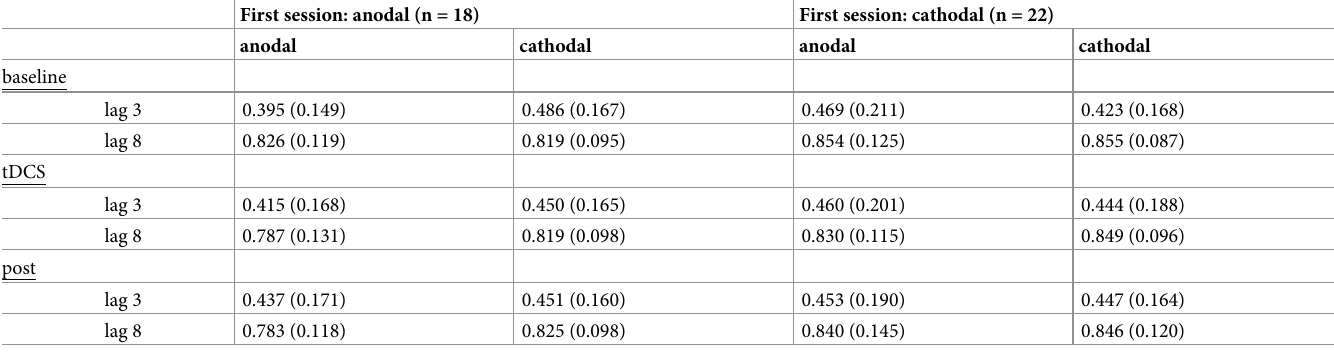
Table 1. Descriptive statistics for T2|T1 accuracy.